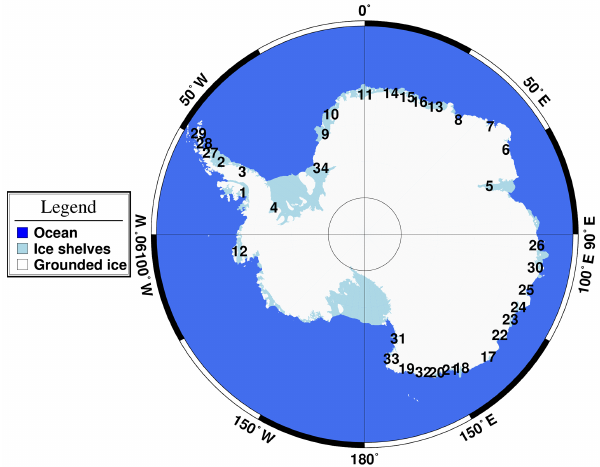
Figure 3. The location of each of the ice shelf regions in our analysis.